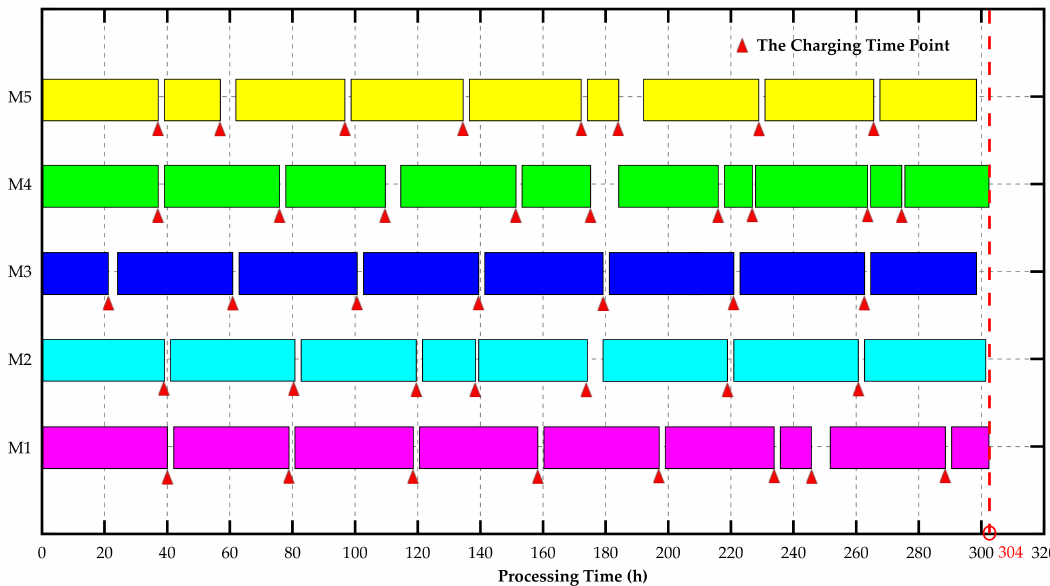
Figure 2. The time distribution of charging for wireless sensors and continuous processing for five machines based on